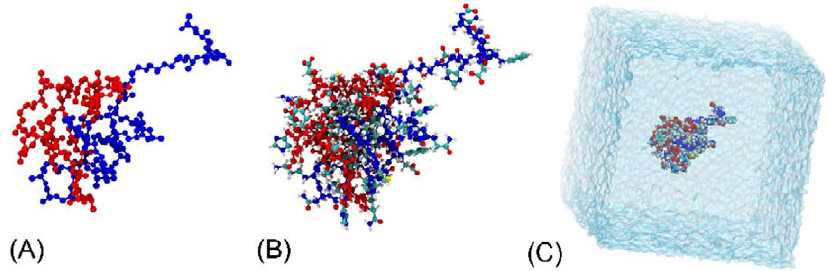
Figure 1. Reconstruction of fully atomistic A b dimers from the DMD-derived four-bead A b dimer conformations. (A) A four-bead A b 1 { 40 dimer containing two peptides depicted in red and blue; (B) A fully atomistic dimer structure; (C) The all-atom dimer inserted in a cubic water box. Images were created by the VMD software package [ 90 ] .